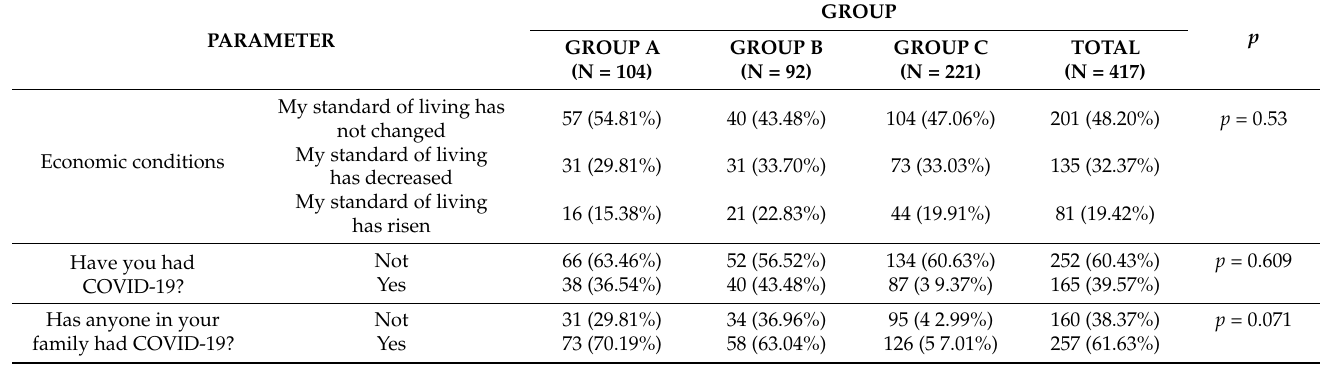
Table 3. Differences between groups on COVID-19 variables, economic situation, and sources of